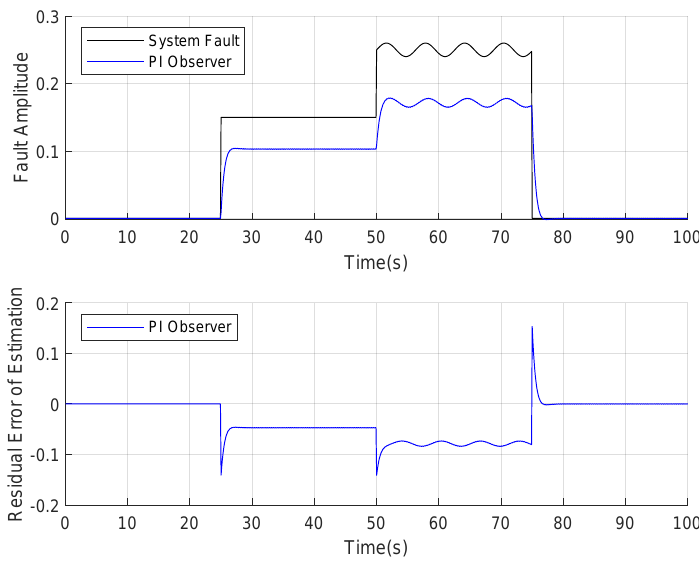
Figure 3. Fault estimation results of proportional integral (PI)